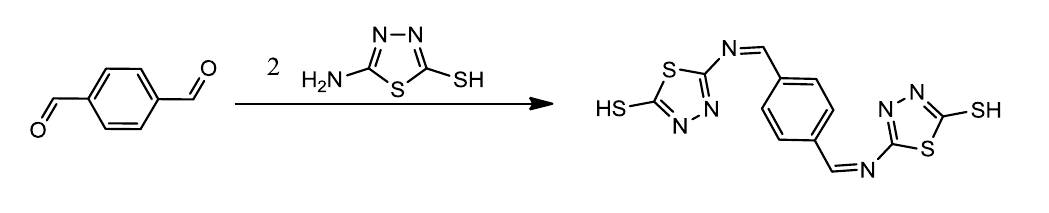
Figure 2. Proton NMR for